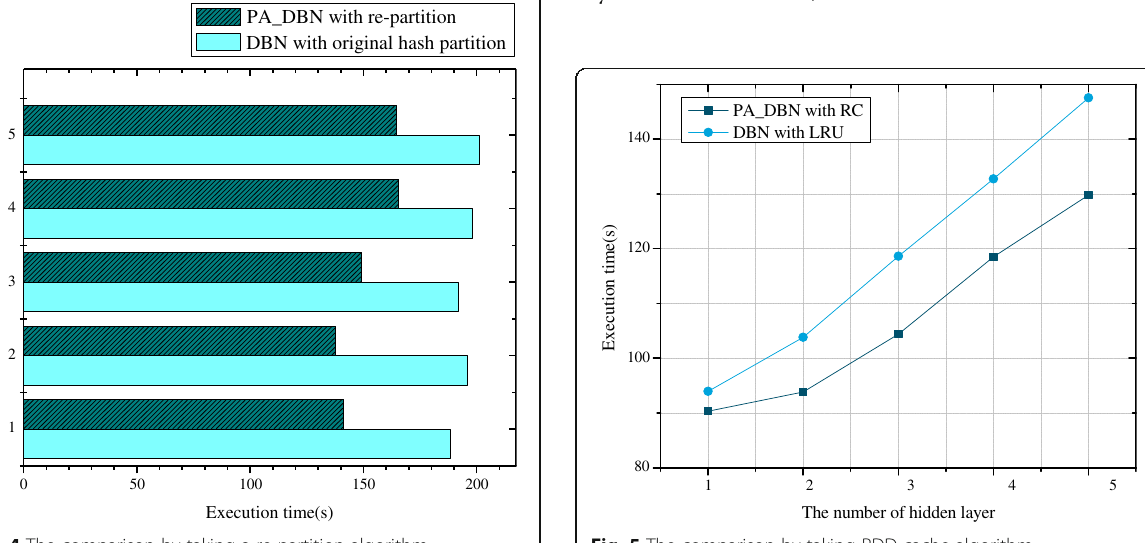
Fig. 4 The comparison by taking a re-partition algorithm